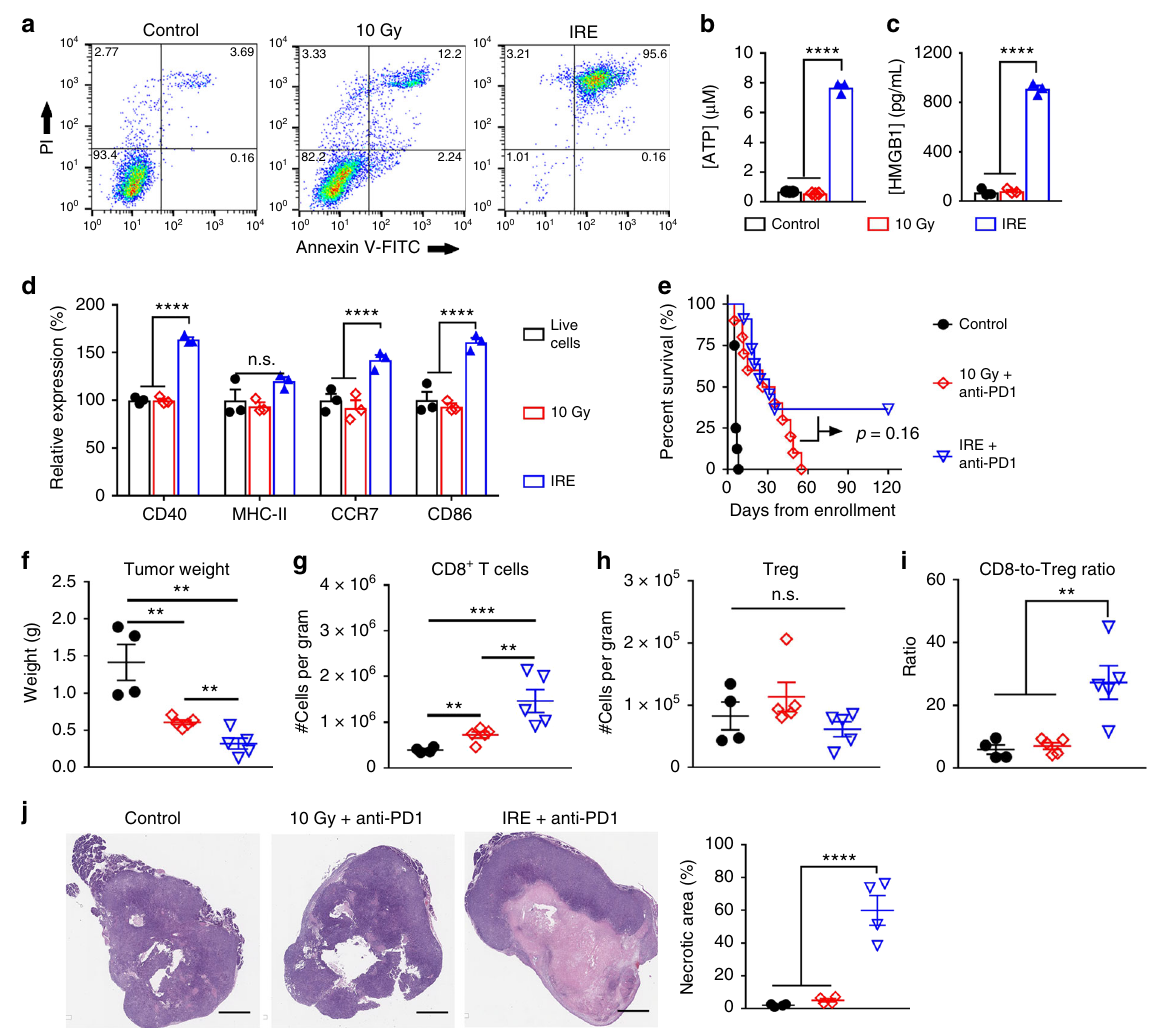
Fig. 8 Comparison between radiation and IRE in the enhancement of anti-PD1 therapy. a Annexin V-FITC / PI staining of KRAS* suspended in phosphate buffered saline (PBS) after 10 Gy of radiation, or electroporated using 960-V, 100- µ s electric pulses at 1 Hz frequency for 20 pulses in a 4 mm-gap cuvette. b , c ATP and HMGB1 concentrations in the cell supernatants of control (black bar), 10 Gy (red bar), and IRE (blue bar) ( n = 3). Cells were analyzed within 30 min of treatments. d Representative expression of DC activation markers, including CD40, MHC-II, CCR7, and CD86, on bone marrow-derived DCs (CD11c + ) after incubation with KRAS* cells for 24 h. Expression was quanti fi ed via geometry mean fl uorescence intensity (MFI; n = 3). e Kaplan – Meier survival curves of mice in sham control (black solid circle, n = 8), 10 Gy + anti-PD1 (red diamond, n = 10), and IRE + anti-PD1 groups (blue triangle, n = 11). f – i Tumor weight, frequencies of intratumoral CD8 + T cells and Treg, and CD8-to-Treg ratios from 4 to 6 tumors per group collected at 9 days after radiation or IRE. j Representative hematoxylin – eosin staining of tumor sections and quanti fi cation of tumor necrosis. Scale bar = 2 mm. Data are presented as mean ± standard error of mean (SEM). Signi fi cance was determined using 1-way ANOVA followed by Tukey post hoc analysis or Student ’ s t -test. * p < 0.05, ** p < 0.01, **** p < 0.0001, n.s. not signi fi cant. Source data are provided as a Source Data fi